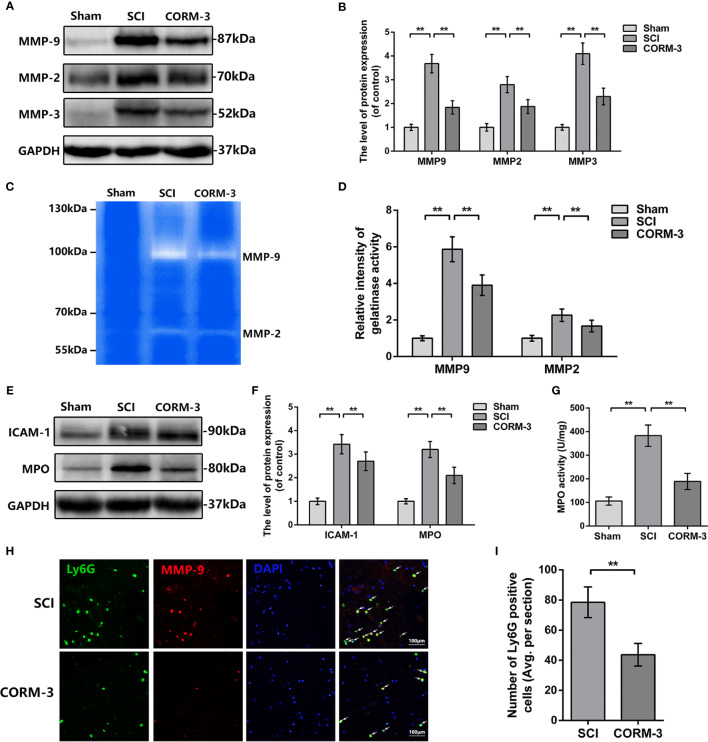
CORM-3 blocks the neutrophil infiltration and inhibits MMP-9 production and activation at 3 days after SCI. (A, B) The protein expression of ICAM-1 and MPO in spinal cord at 3 days post-SCI. (C) MPO activity in spinal cord at 3 days post-SCI. (D, E) The protein expression of MMP-2, -3, and -9 in spinal cord at 3 days post-SCI. (F, G) Dual immunofluorescence of MMP-9 and Ly6G in segments from tissues at 3 days post-SCI (bar: 50 μm). The white arrow indicates the Ly6G/MMP-9 positive cells. (H, I) Representative zymography and measurement data of MMP-2 and -9 in spinal cord at 3 days post-SCI. All data is denoted as mean ± S.D. (n = 5). **P < 0.01.